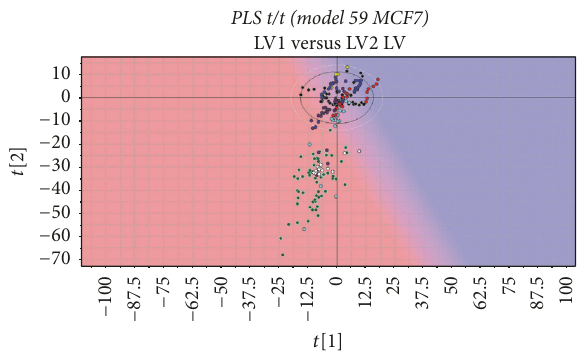
Figure 1: PLS 𝑡/𝑡 scores plot for the 176 selected compounds.